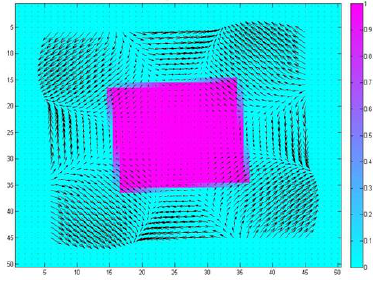
Figure 21. Results of Lucas/Kanade (Win=5,